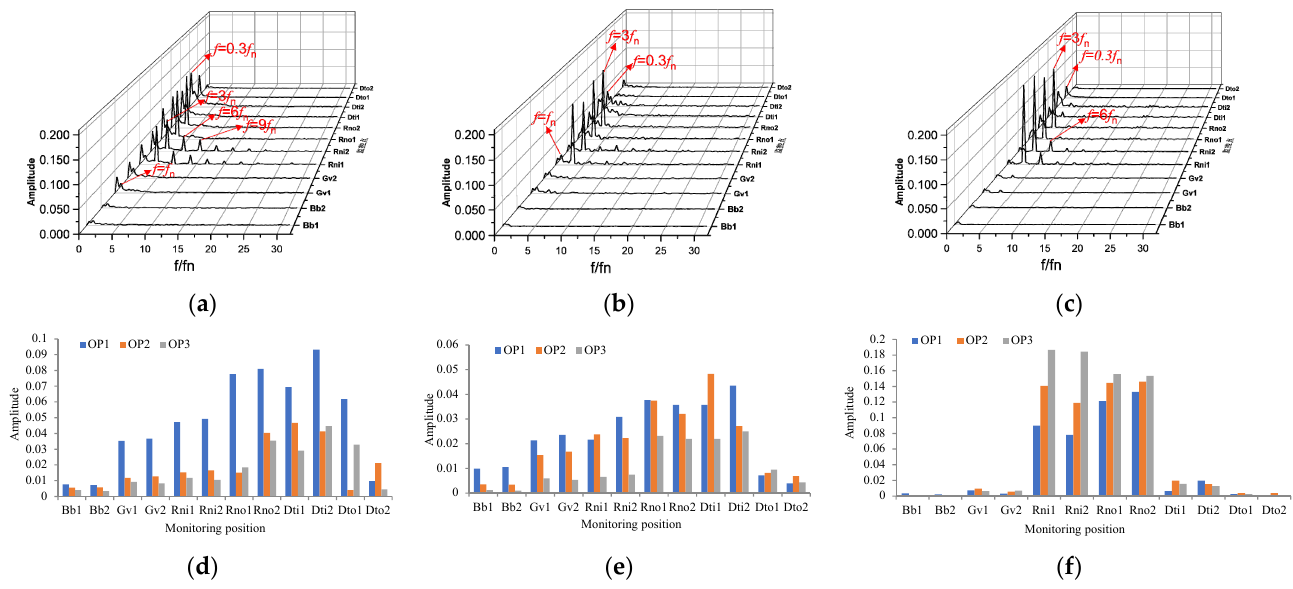
Figure 11. Pressure spectrum of different monitoring points under different conditions: ( a ) Operation condition 1; ( b ) operation condition 2; ( c ) operation condition 3; ( d ) 0.3 fn; ( e ) fn; ( f ) 3 fn.